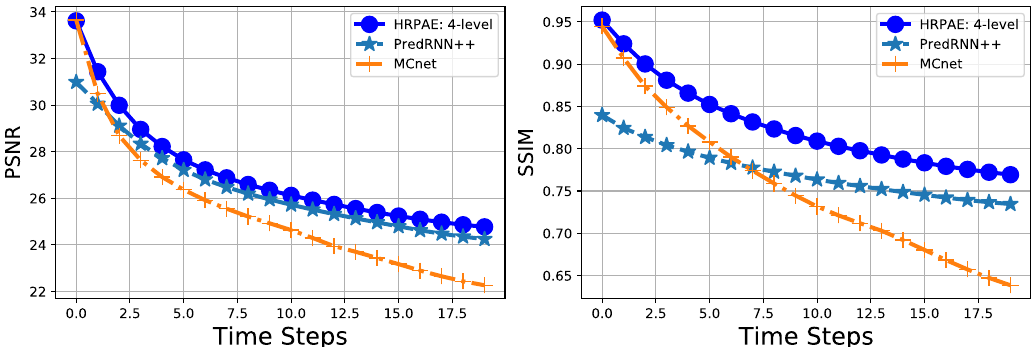
Figure 6. Frame-wise performance on the KTH dataset. Table 4. Results with the KTH human action dataset. The metrics are averaged over 20 predicted